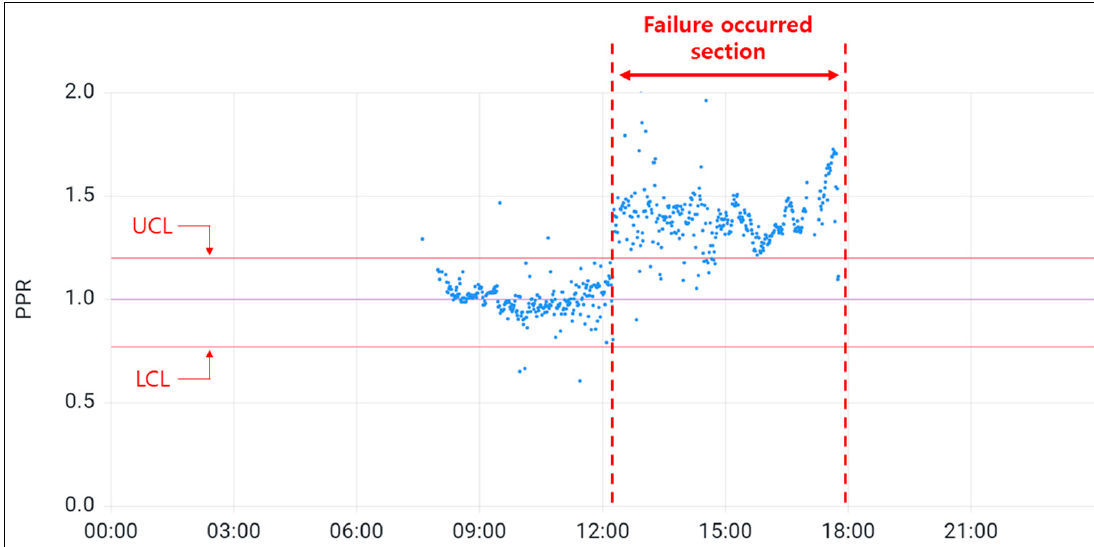
Figure 9. Predicted and measured power generation in abnormal operation.